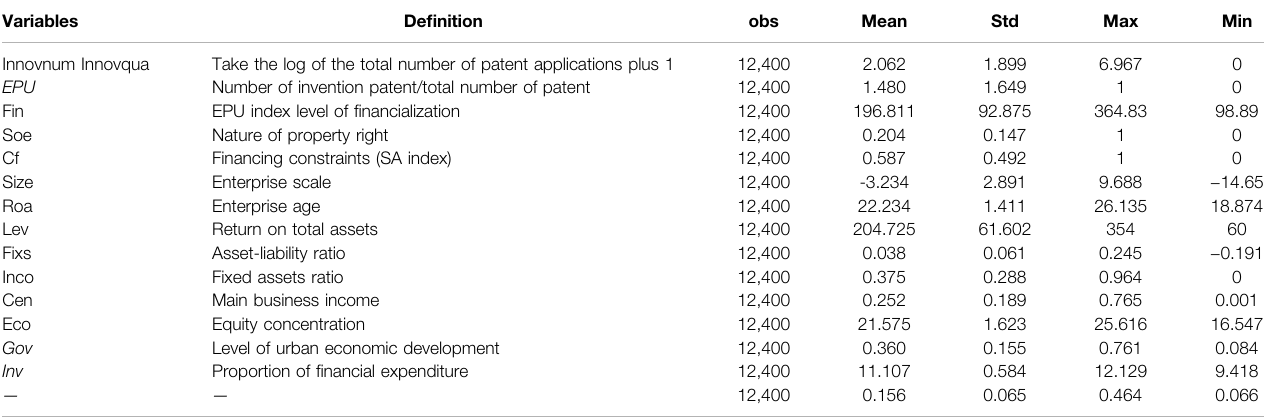
TABLE 1 | Variable de fi nitions and descriptive statistical